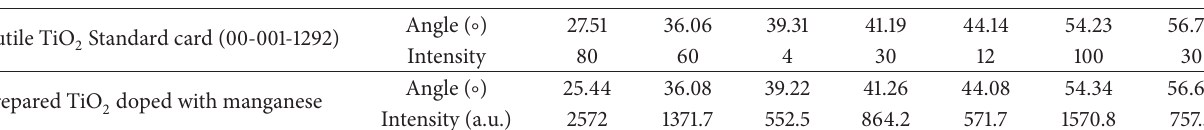
standard card and prepared TiO 2